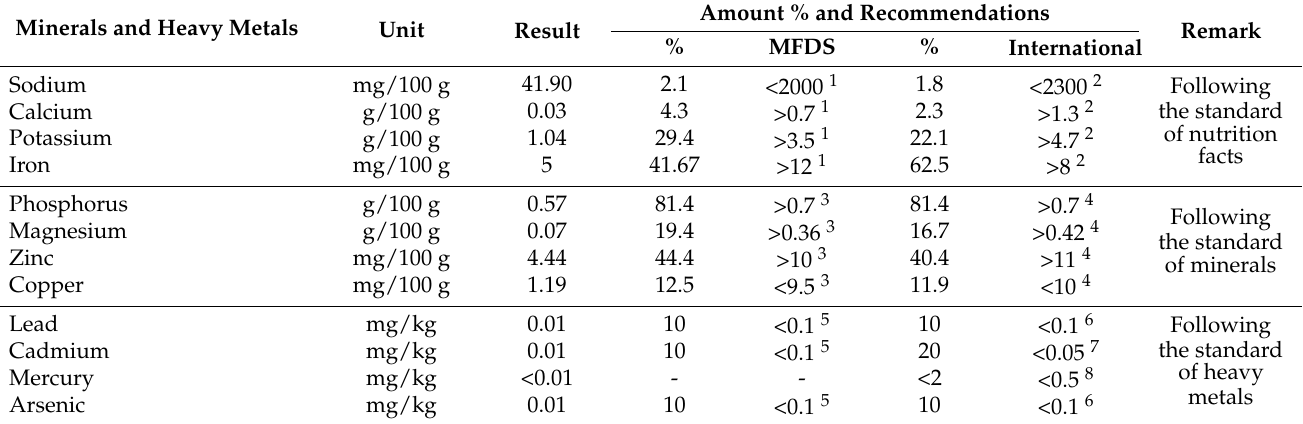
Table 9. Analysis of the mineral and heavy-metal composition of the optimal drone pupae powder.